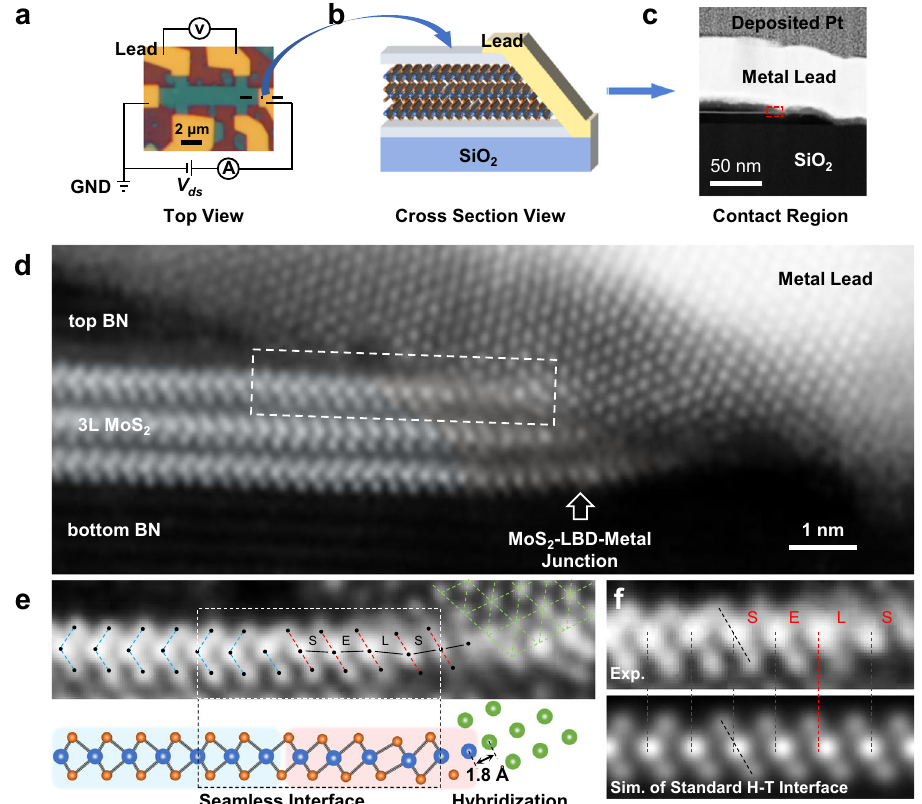
Fig. 3 Atomic-scale observation of the LBD contact in MoS 2 . a Top-view optical image of a typical 3L-MoS 2 FET. The dash-dot line indicates the cutting position in the source, from which a cross-section membrane as illustrated in the schematic ( b ) was extracted using the focused ion beam (FIB) method. c The low-magni fi cation ADF image of the contact region. The area in the red-dash rectangle is zoomed in as ( d ). d Atomic-resolution ADF image of the MoS 2 -LBD-metal junction observed along the MoS 2 zig-zag direction. The fi rst layer of MoS 2 is analyzed in ( e ) with the corresponding atomic model shown below. The overlaid blue, red and green dashed lines highlight the lattices of hexagonal MoS 2 , octahedral MoS 2 and metal lead, respectively. f The Mo – Mo bond-length comparison (E equal, S short, L long) between the experimental measurement and the simulated standard structure. The red dashed lines mark the positions of Mo atomic columns in the experimental data while the black dashed lines indicate the S-Mo-S unit from which the distortion